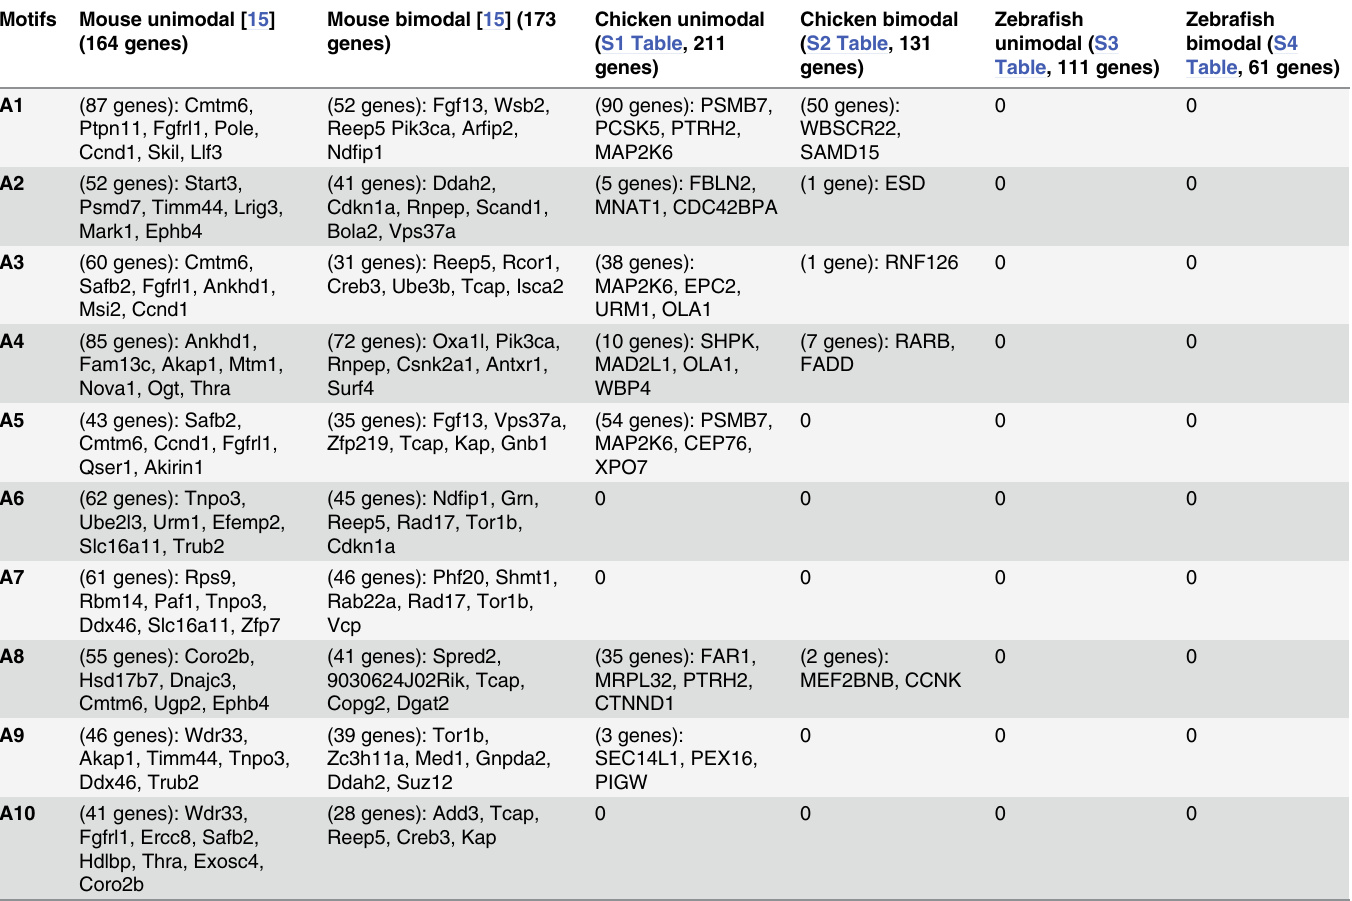
Table 6. Motif enrichment in the lists of candidate cyclic genes from mouse, chicken, and zebrafish datasets. We have compiled the lists of candidate cyclic genes with one and two peak of expression during mouse, chicken, and zebrafish somitogenesis and tested them against the reference of regulatory motifs. For each species, we reported the number of genes containing the corresponding motif in their promoter as well as the genes with the highest E-val- ues. These genes represent leading cyclic candidate genes. As expected, none of the motifs discovered in mouse was found to be overrepresented in the promoter of zebrafish candidate cyclic